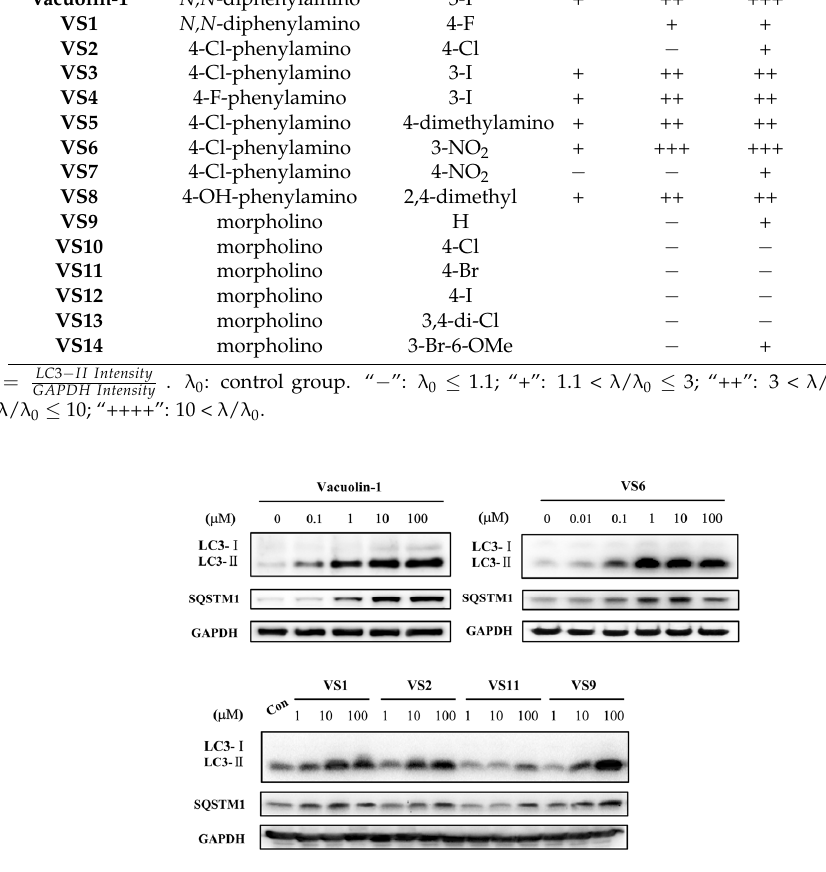
Figure 1. Vacuolin-1 analogues identified via virtual screening induced the accumulation of both LC3B-II and SQSTM1 in HeLa cells in a dose dependent manner after a 6 h treatment.